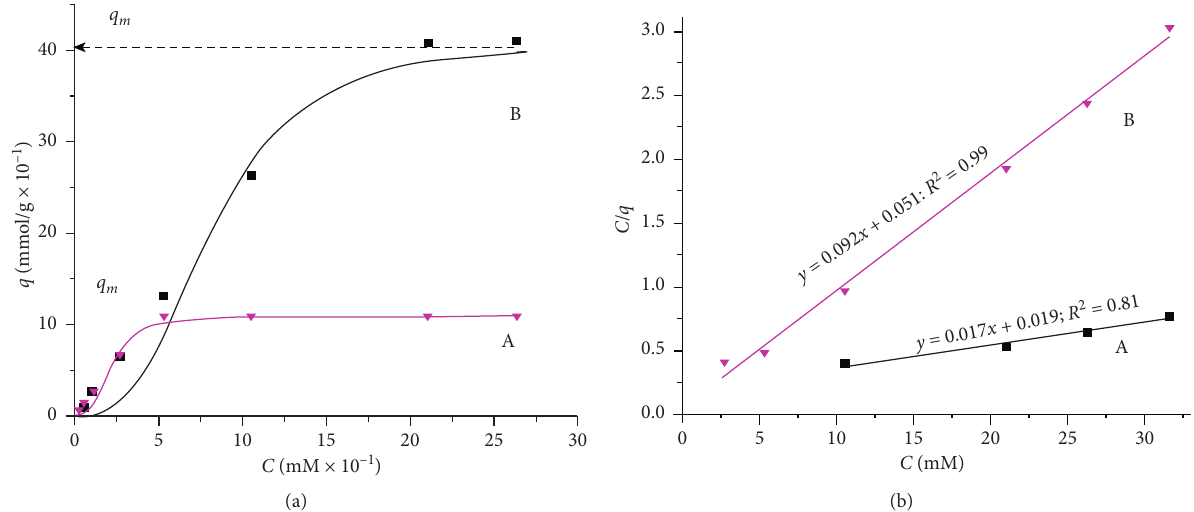
Figure 11: (a) Optimal sorbed amounts of fluoride anions from aqueous media; (b) Langmuir fit curves for (A) LEuH-Cl aggregates and (B) LEuH-flocs nanosheets.